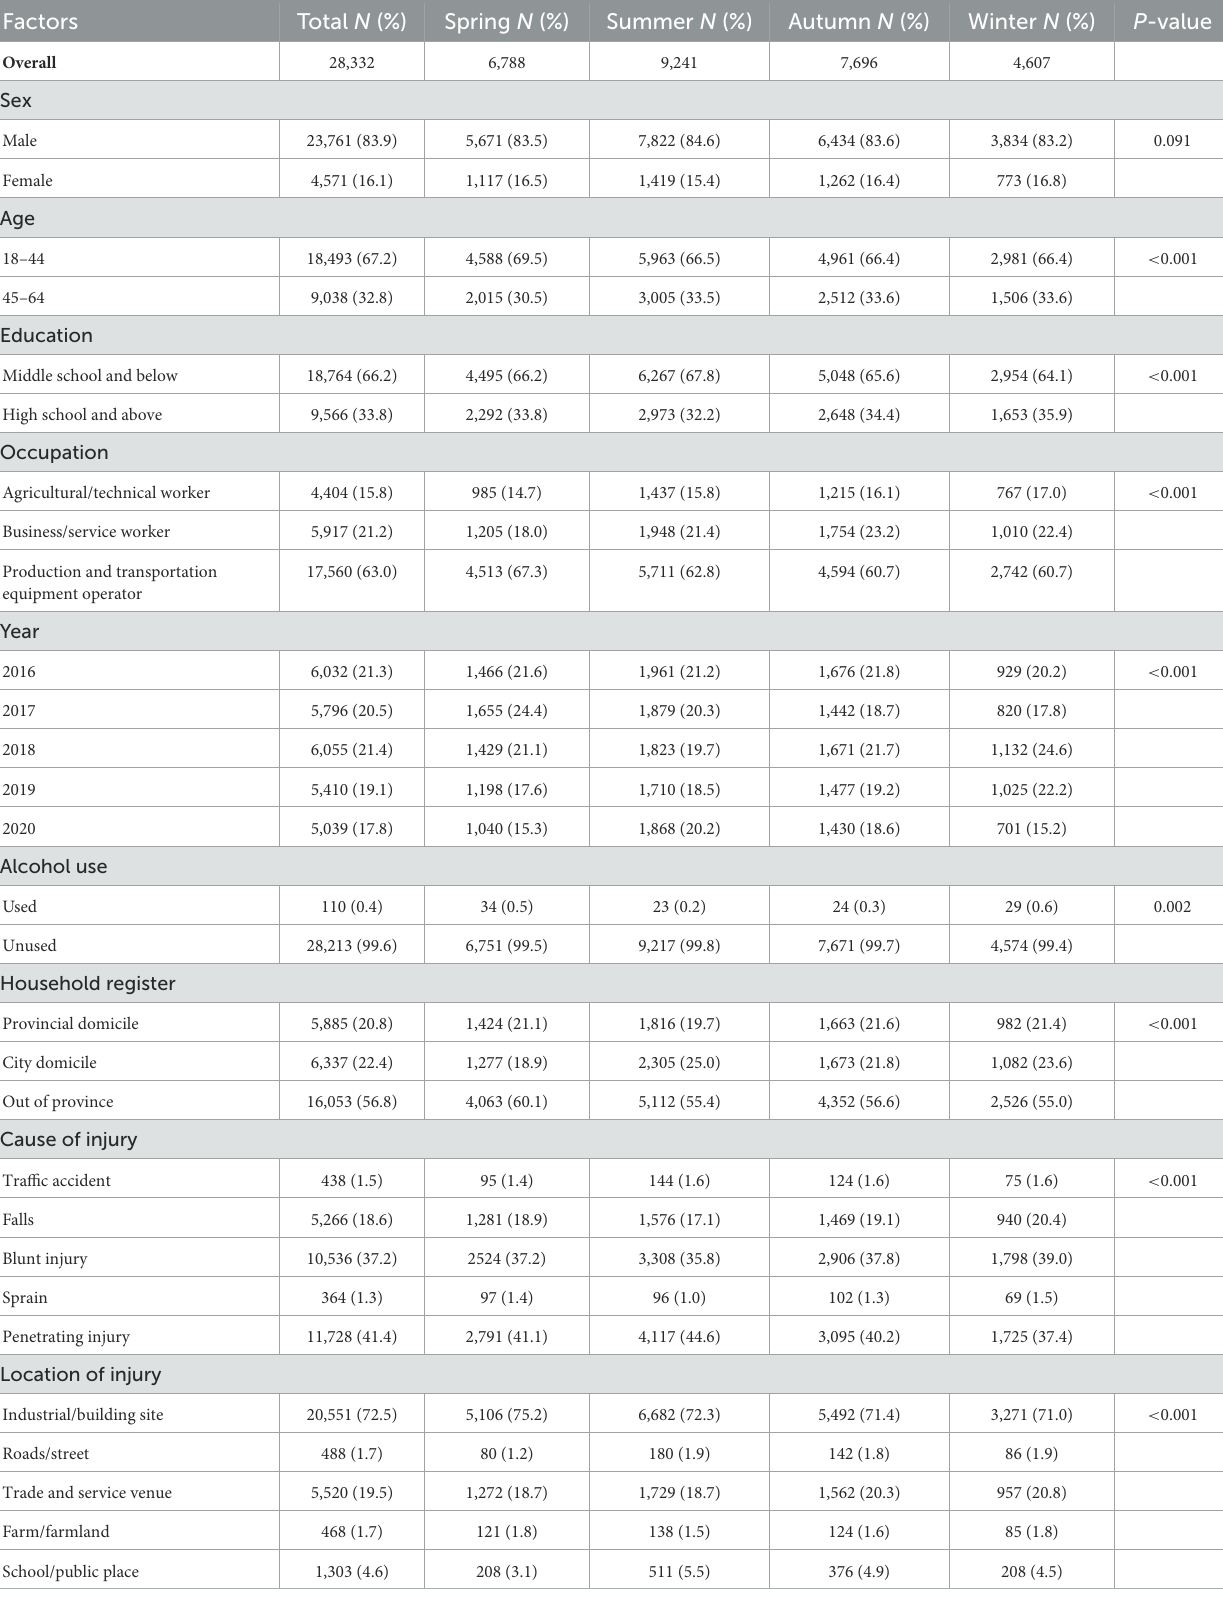
TABLE 1 Characteristics of participants eligible for work-related injuries at injury sentinel monitoring hospitals in Guangzhou, China, by season 2016–2020 ( n = 28,540).